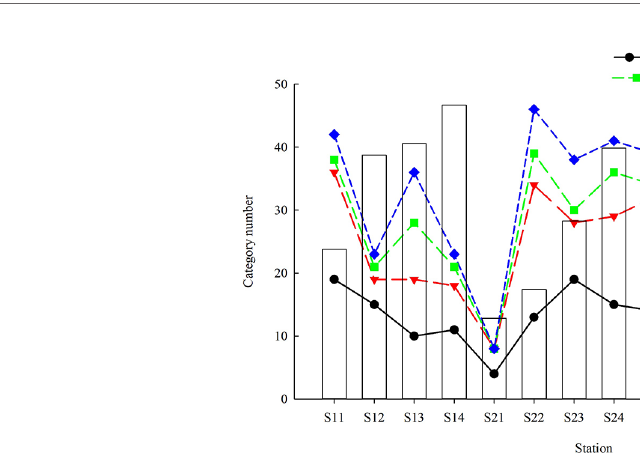
FIGURE 3 | Depth dependence of demersal fi sh species richness over the NCSSCS.